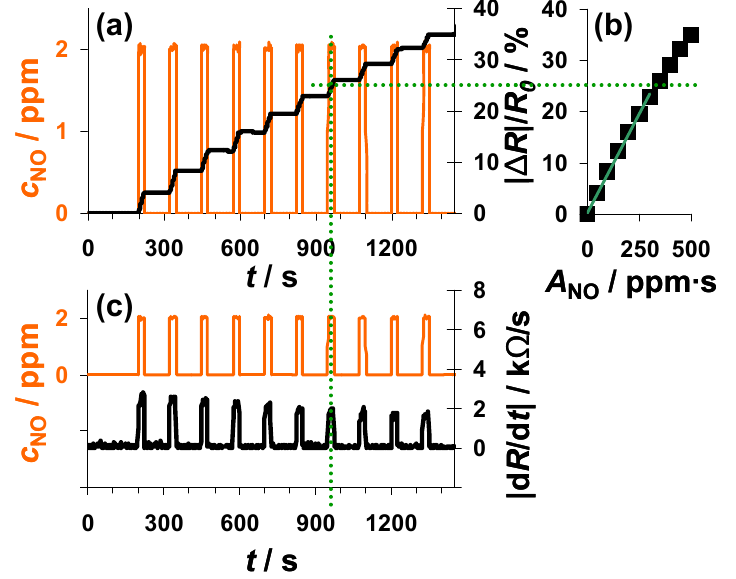
Figure 4. Sensor response on 10 pulses of 2 ppm NO each for 25 s alternating with 0 ppm for 100